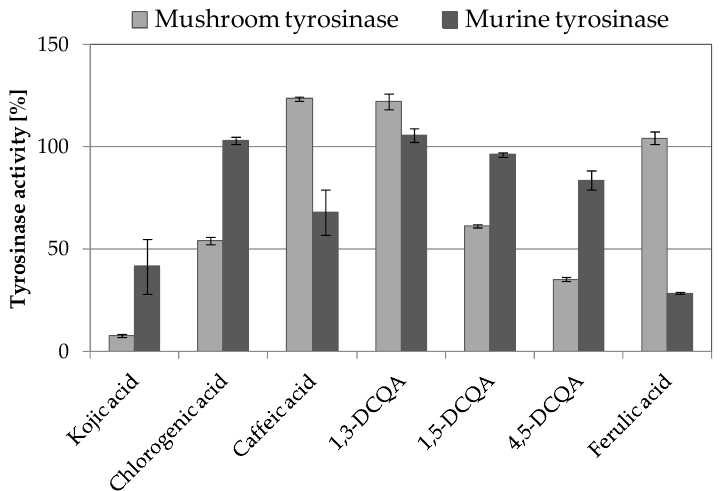
Figure 7. Mushroom and murine tyrosinase inhibitory activity of 100 µg/mL pure major compounds identified in F12, F25, and F27 A. biebersteinii fractions; 100 µg/mL kojic acid (KA) was used as a positive control; graph shows mean values ± SD, n = 3 .